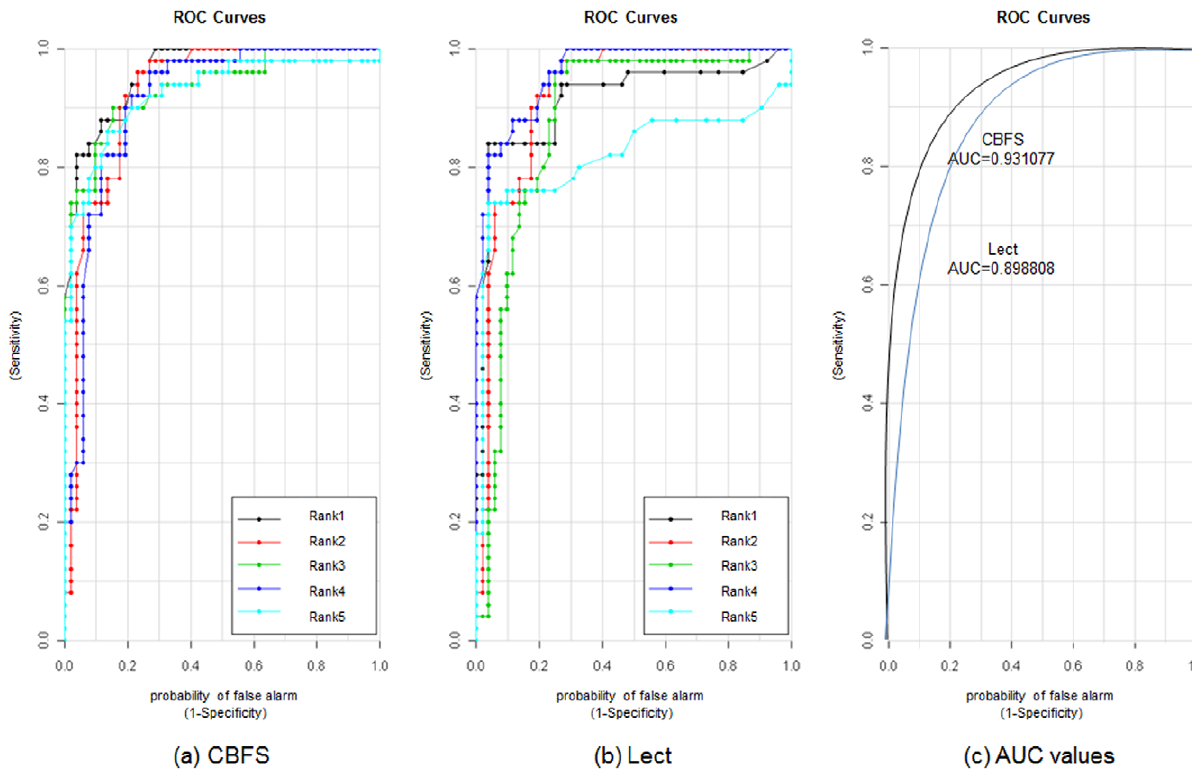
Figure 9. ROC curve and AUC values for CBFS and Lect feature selection algorithms on Prostate dataset.